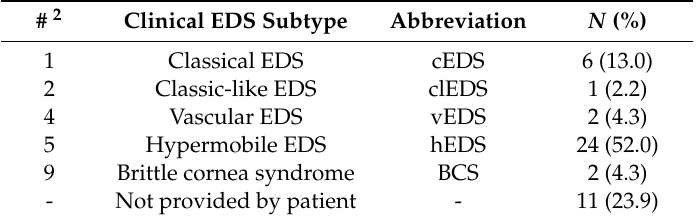
Table 3. Contribution of the subtypes of Ehlers–Danlos syndromes (EDS) in the study cohort. # 2 Clinical EDS Subtype Abbreviation N (%) Classical EDS cEDS Classic-like EDS Vascular